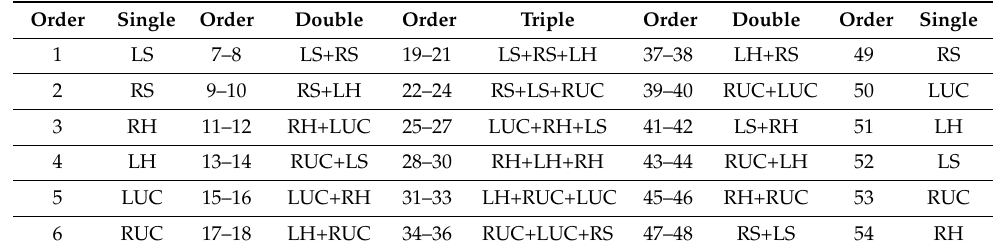
Table 1. An example of 1 round of shadow boxing.